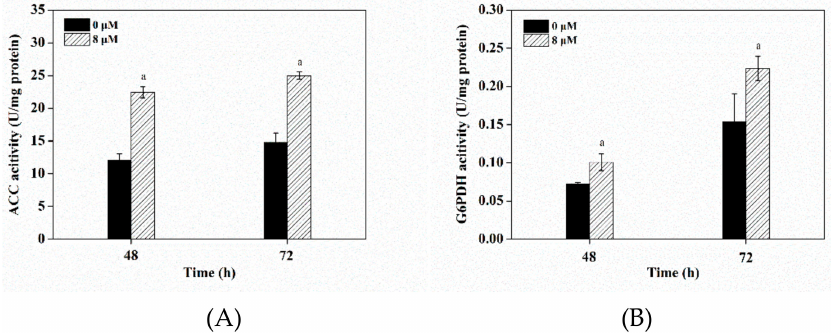
Figure 6. ( A ) Acetyl-CoA carboxylase (ACC) enzyme activities and ( B ) Glucose-6-phosphate dehydrogenase (G6PDH) enzyme activities in the control and 8 µ M triclosan treatment. Significant di ff erence between control and triclosan treatment group is indicated at p < 0.05 (a), p < 0.01 (b), or p < 0.001 (c) level. All data are expressed as mean ± S.D. of three independent